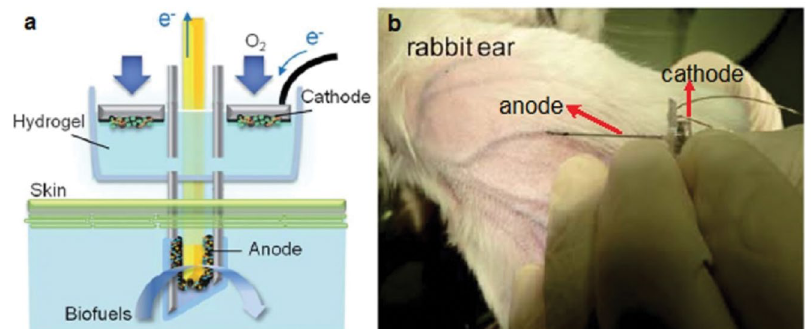
Fig. 14. ( a) Schematic structure of a biofuel cell designed to utilize biochemical energy in living organisms [127]. (b) Photographs of the assembled biofuel cell for power generation from a rabbit vein